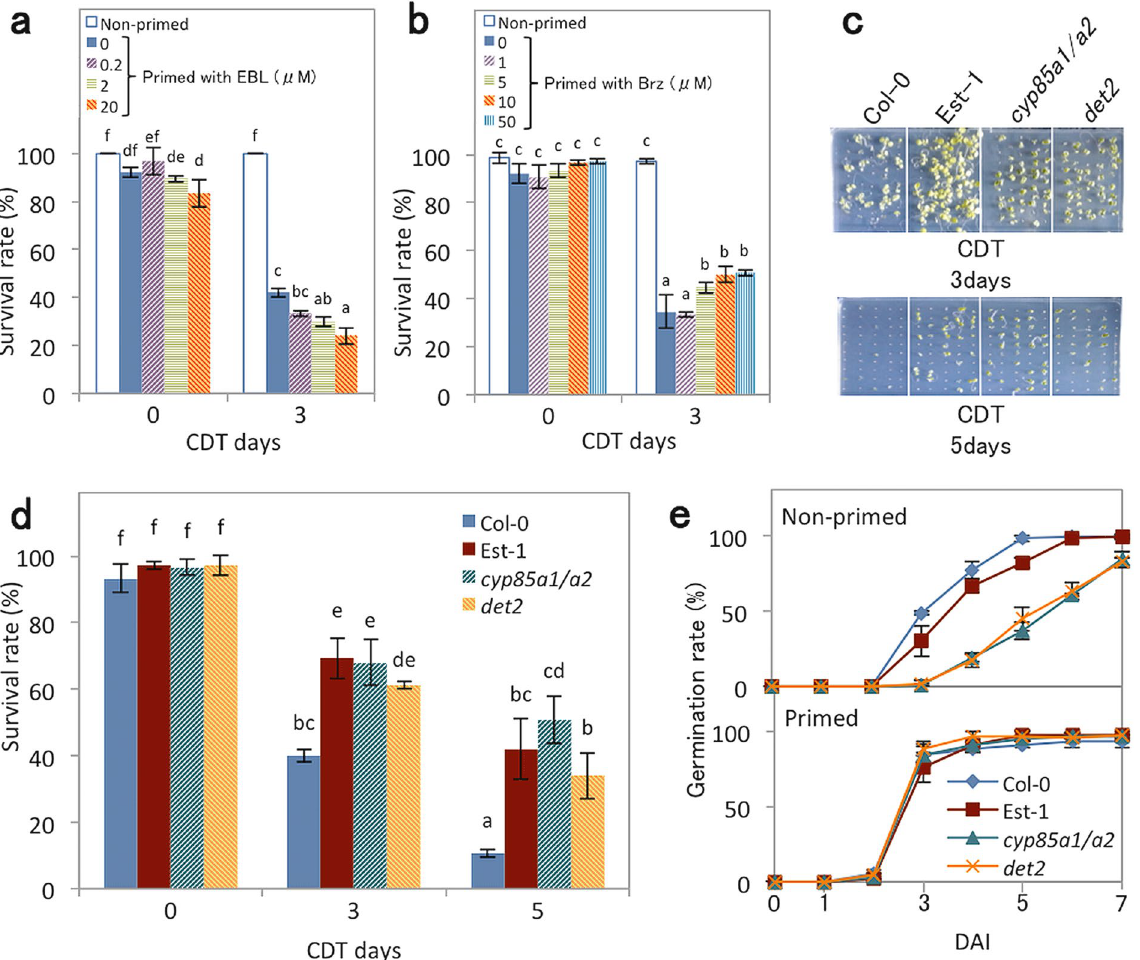
Figure 6. Effect of BR on seed longevity. ( a ) Survival rates of wild type Col-0 non-primed seeds or seeds primed with 0, 0.2, 2 or 20 μ M EBL after 0 or 3 days of CDT. ( b ) Survival rates of wild type Col-0 non-primed seeds or seeds primed with 0, 1, 5, 10 or 50 μ M Brz after 0 or 3 days of CDT. ( c ) Germination of wild type Col-0, Est-1, cyp85a1 cyp85a2 ( cyp85a1 / a2 ) and det2 after priming and subsequent CDT for 3 or 5 days. Photos were taken after 7 days of imbibition. ( d ) Survival rates of wild type Col-0, Est-1, cyp85a1 / a2 and det2 after priming and subsequent CDT for 0, 3 or 5 days. ( e ) Germination speed of wild type Col-0, Est-1, cyp85a1 / a2 and det2 before (non-primed; upper panel) and after (primed; lower panel) without CDT. For ( a ), ( b ), ( d ) and ( e ), values presented are means ± SD of three replicates. Wild type Col-0 (Col-0). Different letters in ( a ), ( b ) and ( d ) indicate significant differences (P < 0.05, Tukey-Kramer